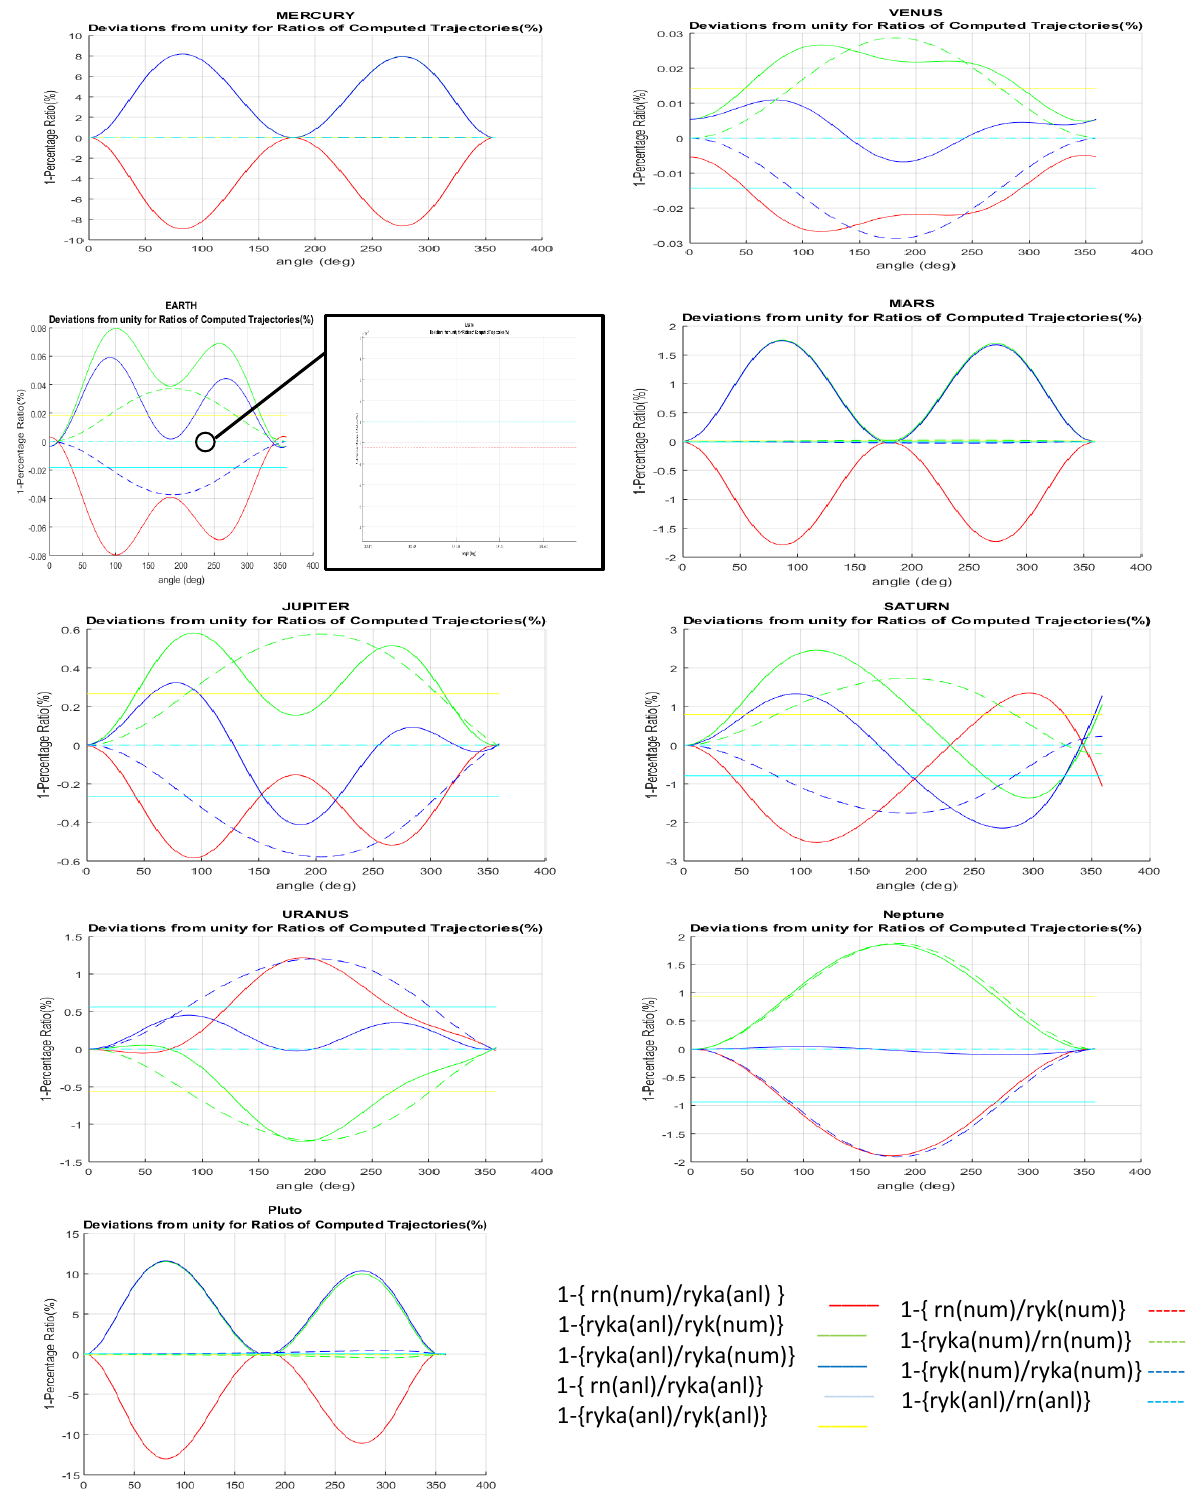
Figure 3. Deviation from unity of ratios of the computed trajectories at each polar angle according to the considered potential (Newton vs. Newton + Yukawa) and/or the used method (numerical vs. analytical) and/or the Yukawa strength determination (nominal vs. estimated). The zoomed region shows, for the generic case of one planet (Earth), that the dashed red and sky blue curves are very near each other; the same applies to the green and blue curves in the case of